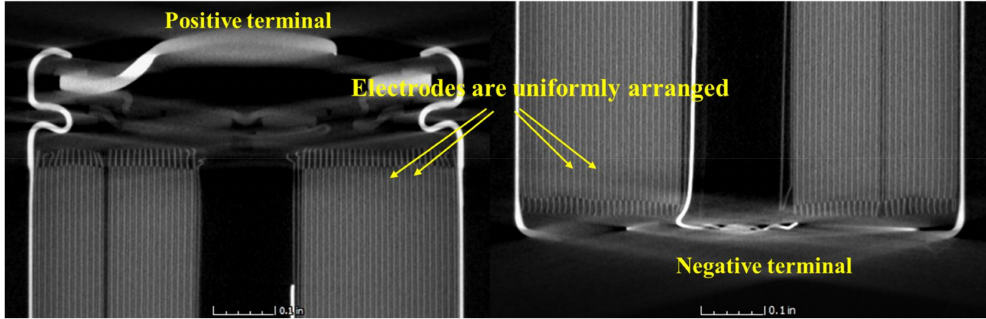
Figure 14. CT scan images near the positive and negative terminals of the sample A2.